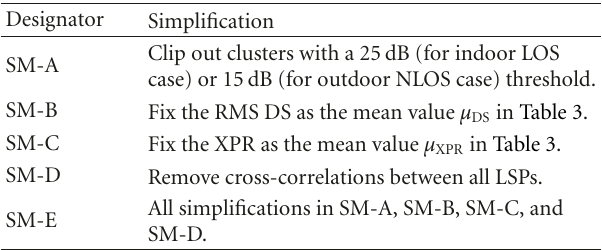
fied cases. Table 5: Designators for simplified